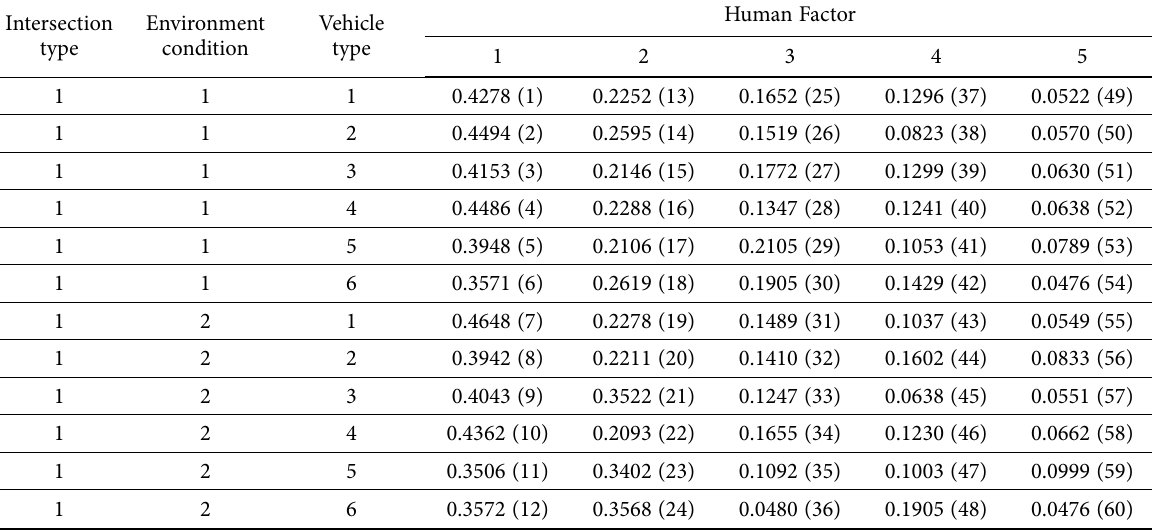
Table 2. Posterior probabilities of human factors